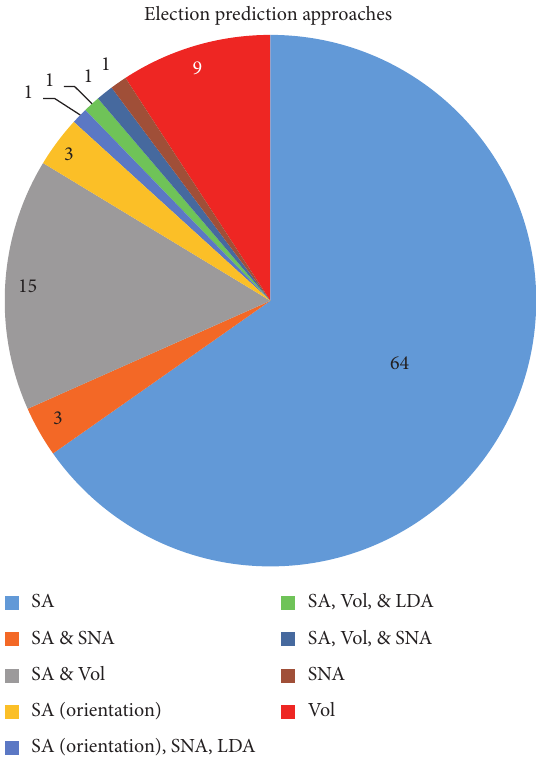
Figure 5: Distribution of election prediction